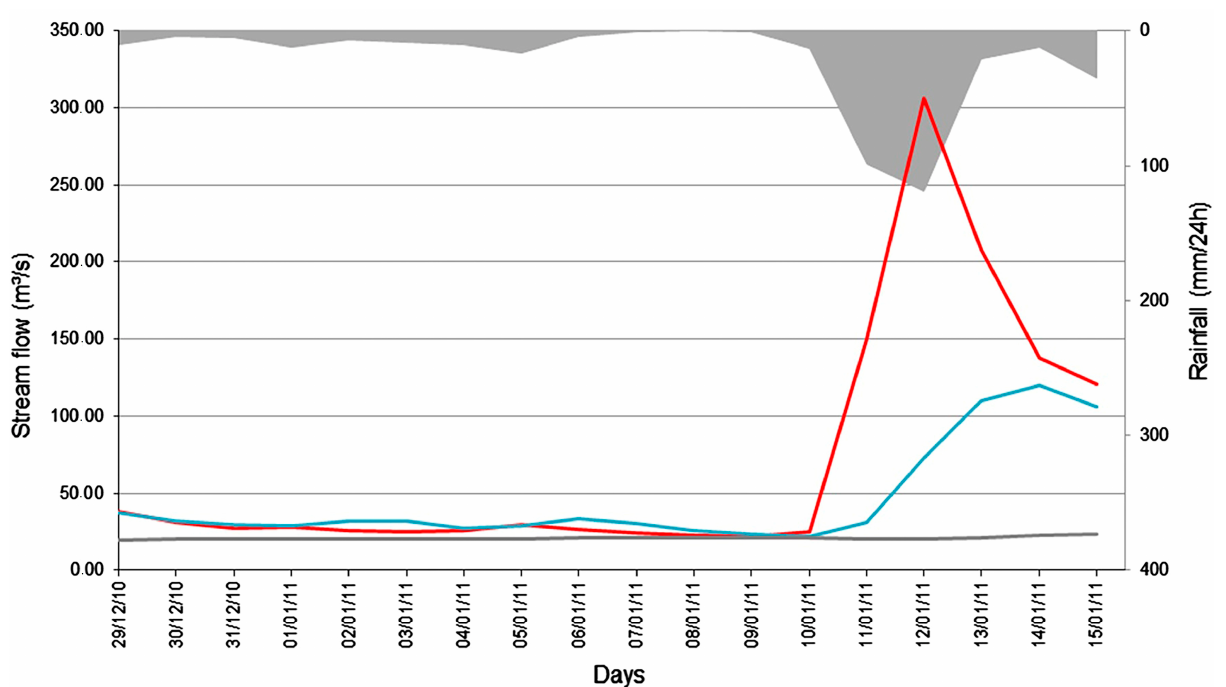
Figure 11. Calibrated comparison between estimated flow and simulated flow in SMAP defined by the left axis, while the right axis represents daily precipitation. Source: Reprinted/adapted with permission from Ref. [17]. 2020. Cavalcante, Barcelos and Cataldi.